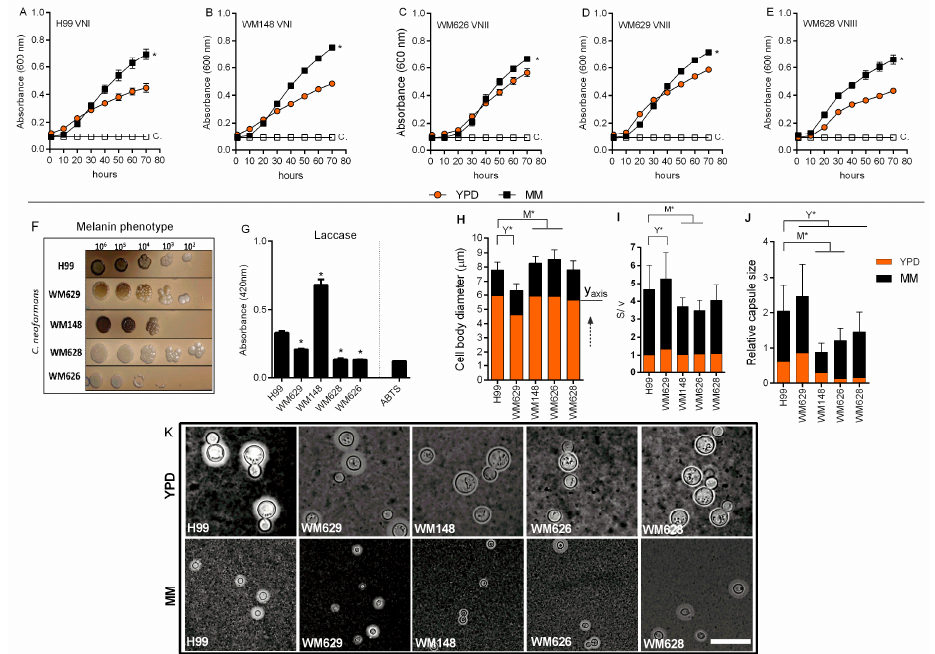
Figure 1. Phenotypic analysis of C. neoformans strains in vitro. ( A – E ) Growth curves of each strain in Yeast Extract Peptone Dextrose (YPD) or in minimal medium (MM) at 37 ◦ C (blank squares represent only the culture media). ( F ) Visual analysis of melanin production after fungal growth in solid minimal medium with L-DOPA at 37 ◦ C for 5 days. ( G ) Laccase activity measured in MM (ABTS: 2,2 (cid:48) -azinobis(3-ethylbenzthiazoline-6-sulfonate). ( H ) Cell body diameter in YPD or in MM at 37 ◦ C after 72 h. Dashed arrow: indicates that the MM y-axis starts at the end of each YPD bar. ( I ) Surface/volume ratio in YPD or in MM at 37 ◦ C after 72 h. ( J ) Relative capsule sizes in YPD or in MM at 37 ◦ C. Mean values were compared with H99 (* p < 0.05; M* = strain analysis on MM; Y* = strain analysis on YPD). ( K ) India ink counter-staining of C. neoformans after growth in YPD or MM. Scale bar: 10 µ